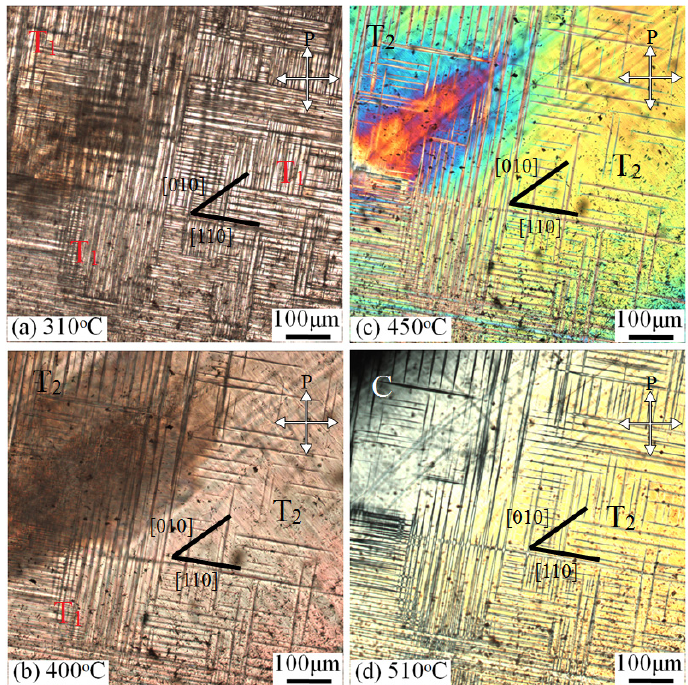
Figure 5. Temperature dependent domain structures in (K ( b ) 400 °C; ( c ) 450 °C; ( d ) 510